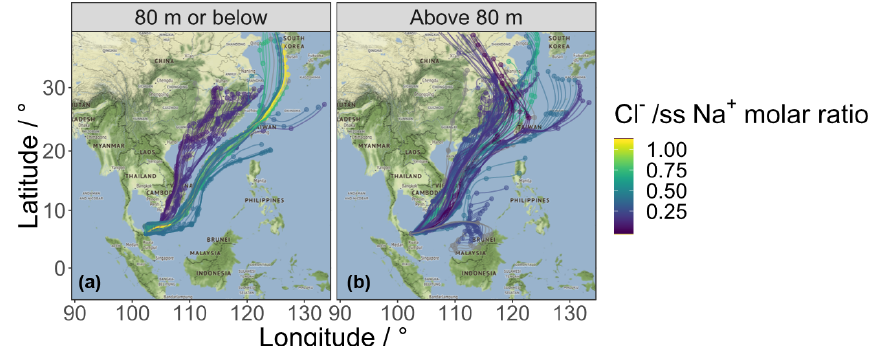
Figure 10. The 7-day HYSPLIT back trajectories centred on the Bachok research station, between 18 January and 7 February 2014. The back trajectories are coloured by the Cl − / ssNa + molar ratio. Trajectories with a mean height of 80m or below are shown in panel (a) and trajectories with a mean height greater than 80m are shown in panel (b)